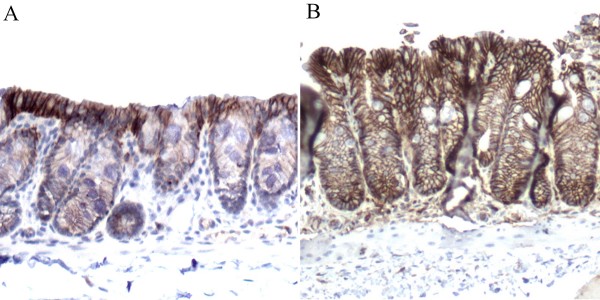
B-catenin cellular localization in WT and CyCAP KO mice. In WT mice, β-catenin expression is higher in the colonic plate than in the crypts of the colon mucosa (A). However, CyCAP KO mice show overall increased membranous expression of β-catenin with irregular distribution, which focally significantly extended into crypts (B). No definite nuclear localization of β-catenin was detected either in WT or KO mice.